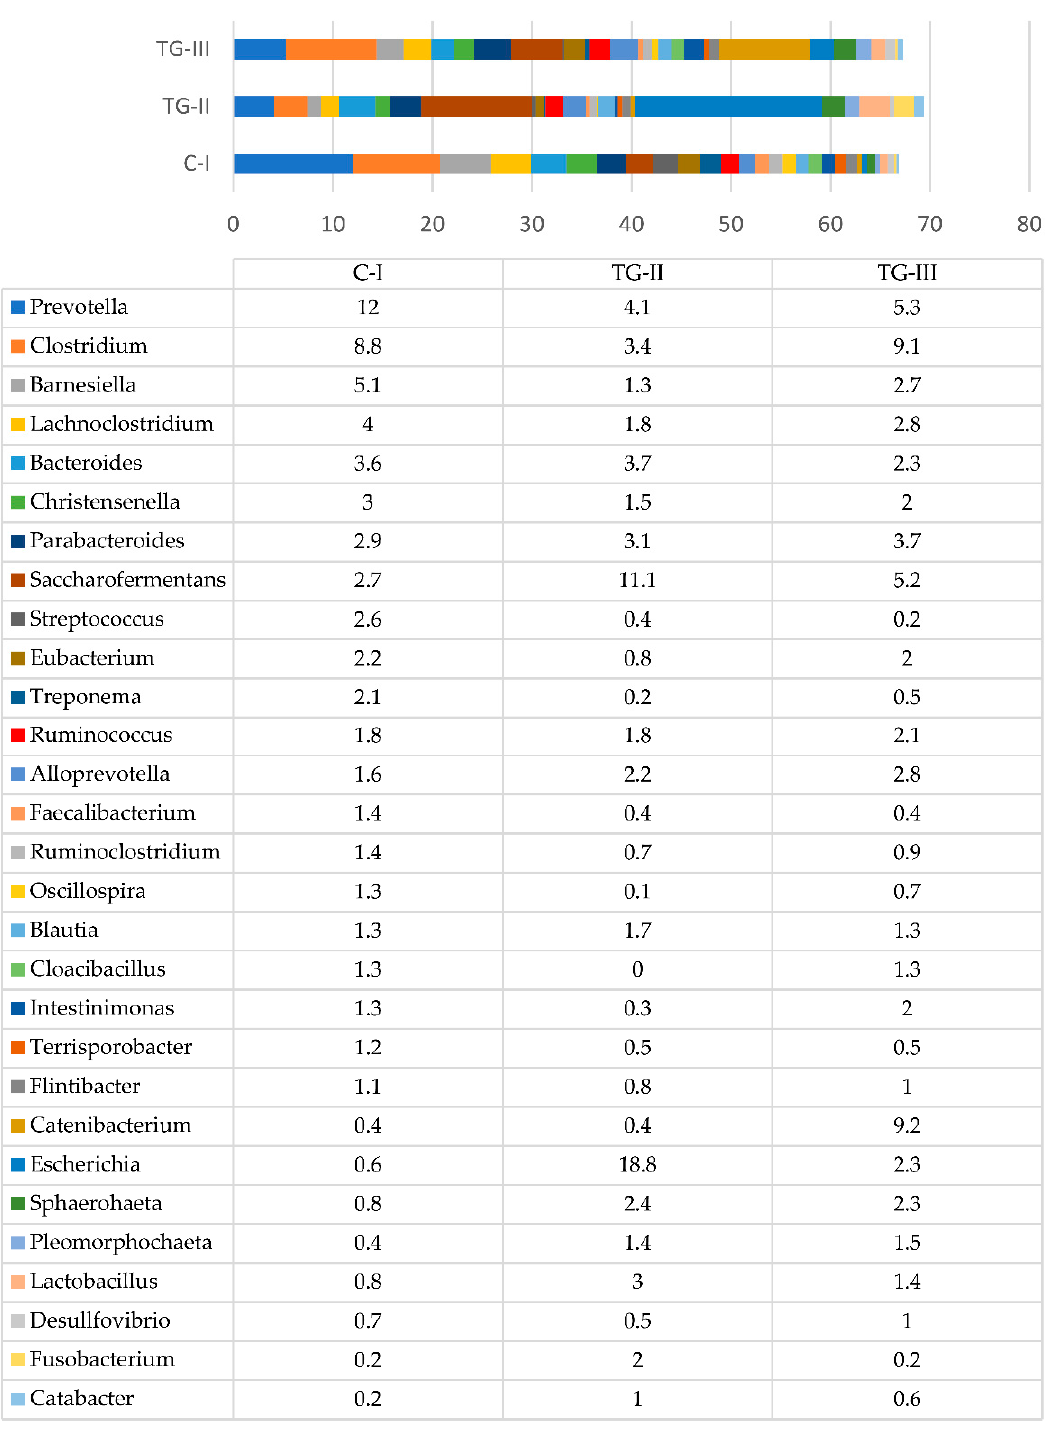
Figure 1. Bacterial genera in faeces of piglets (%) before the experimental treatment (day 21). The data only represent those genera whose numbers from all the bacterial amounts were at least 1% in any of the animal groups.